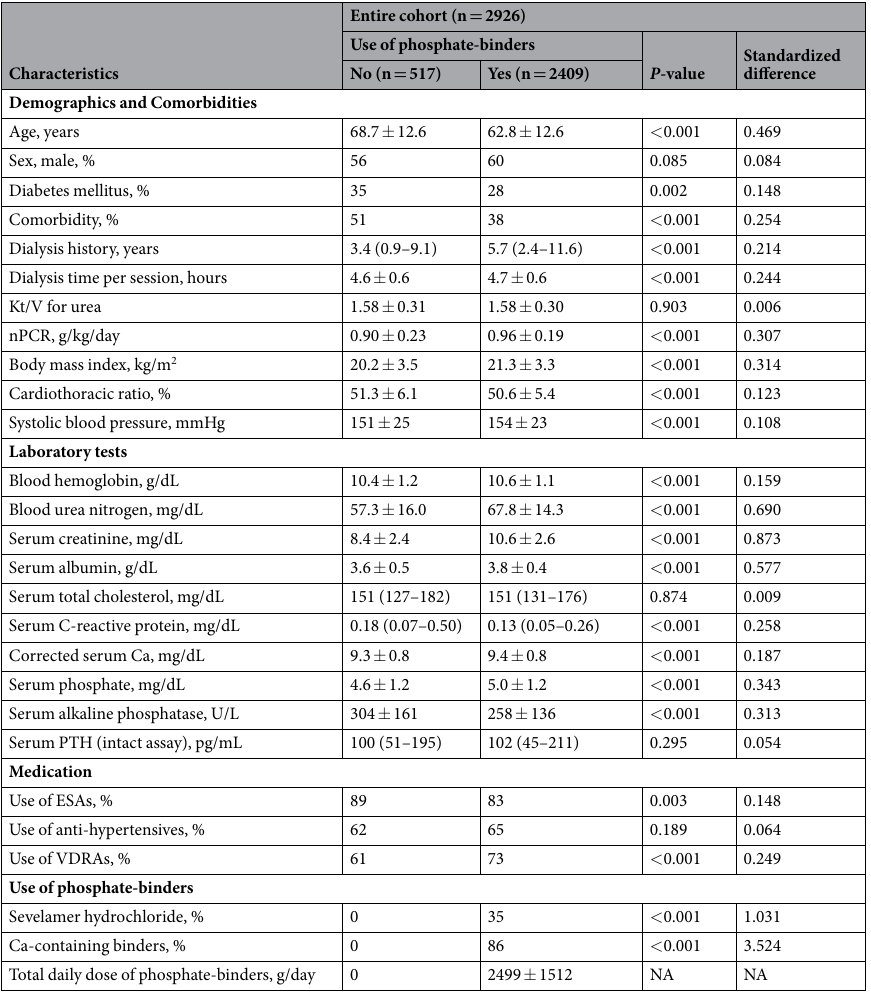
the relative risks of infection-related death among hemodialysis patients with and without P-binders are largely unknown. The present study aimed to compare the risks of infection-related mortality among patients undergoing hemodialysis with or without P-binders. We analyzed the dataset of the Q-Cohort Study, which was a prospec- tive multicenter cohort study of hemodialysis patients in Japan, focusing on nutritional indicators as a potential cofounding factor 16–18 . Results are listed in Table 1. Patients with P-binders had a lower mean age, lower rate of diabetes mellitus (DM), lower incidence of comorbidities, longer median dialysis history, longer mean dialysis time per session, greater mean normalized protein catabolic rate (nPCR) and body mass index (BMI) values, lower cardiothoracic ratio, and higher systolic blood pressure. Mean blood hemoglobin and mean serum albumin, urea nitrogen, creatinine (Cr), corrected calcium, and P levels were higher in subjects with P-binders, whereas mean serum C-reactive protein and alkaline phosphatase levels and the frequency of erythropoiesis-stimulating agent administration were lower